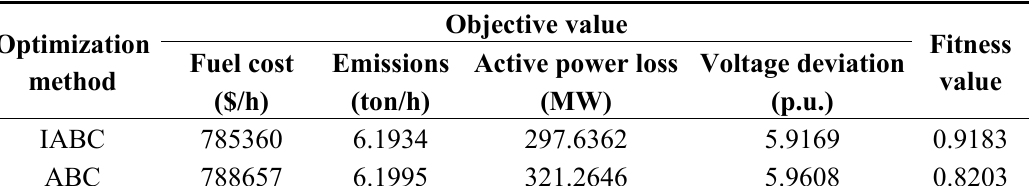
Table 12. Best solutions obtained by the different algorithms for fuzzy multi-objective OPF for the IEEE 300-bus system.